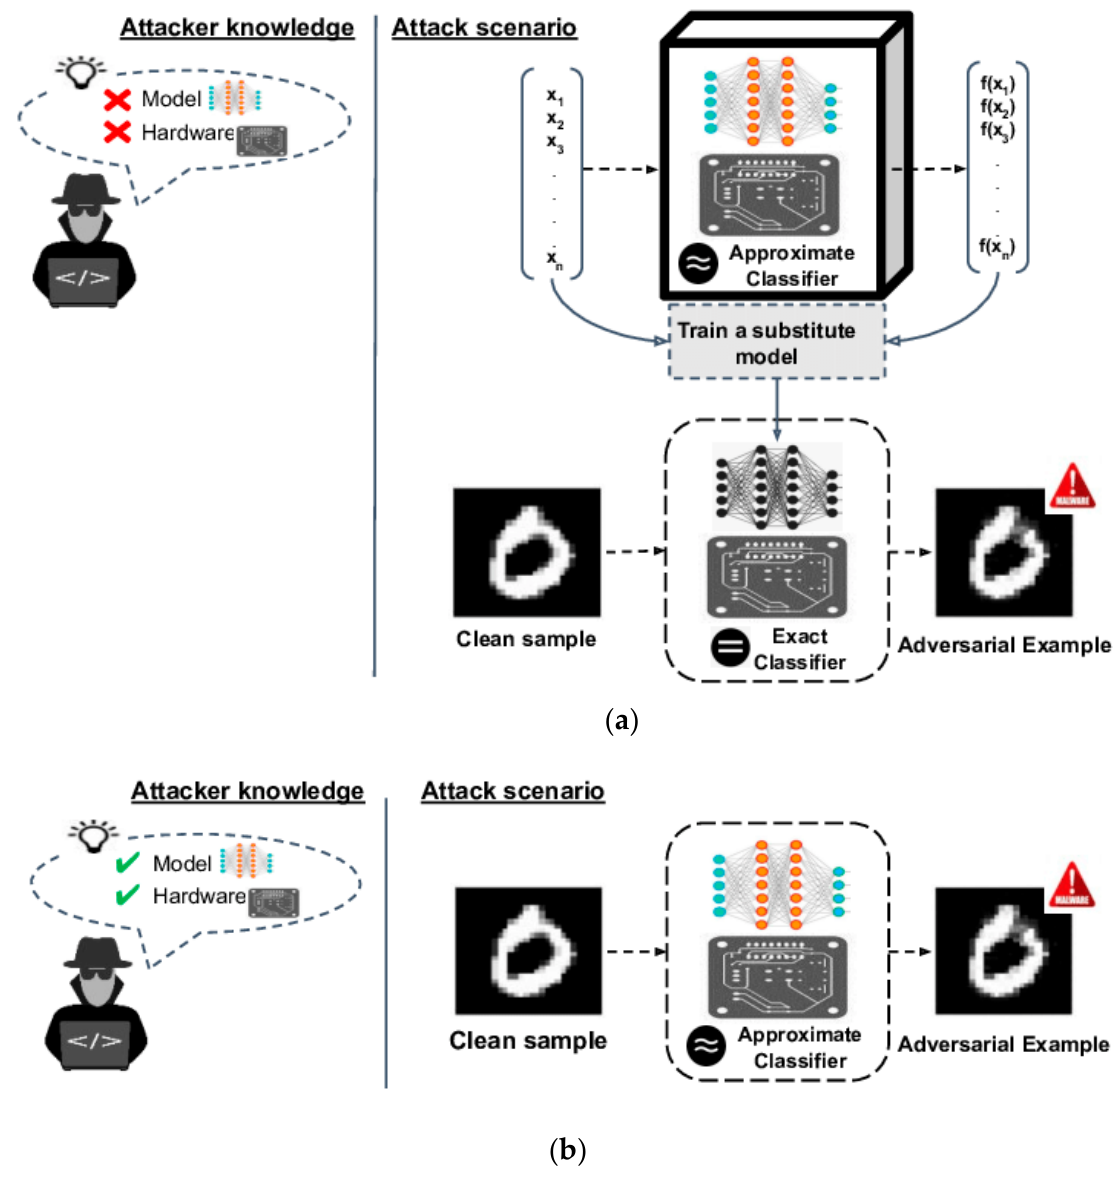
Figure 2. Attacks scenario [8]. ( a ) Black-Box Attack Scenario. ( b ) White-Box Scenario.